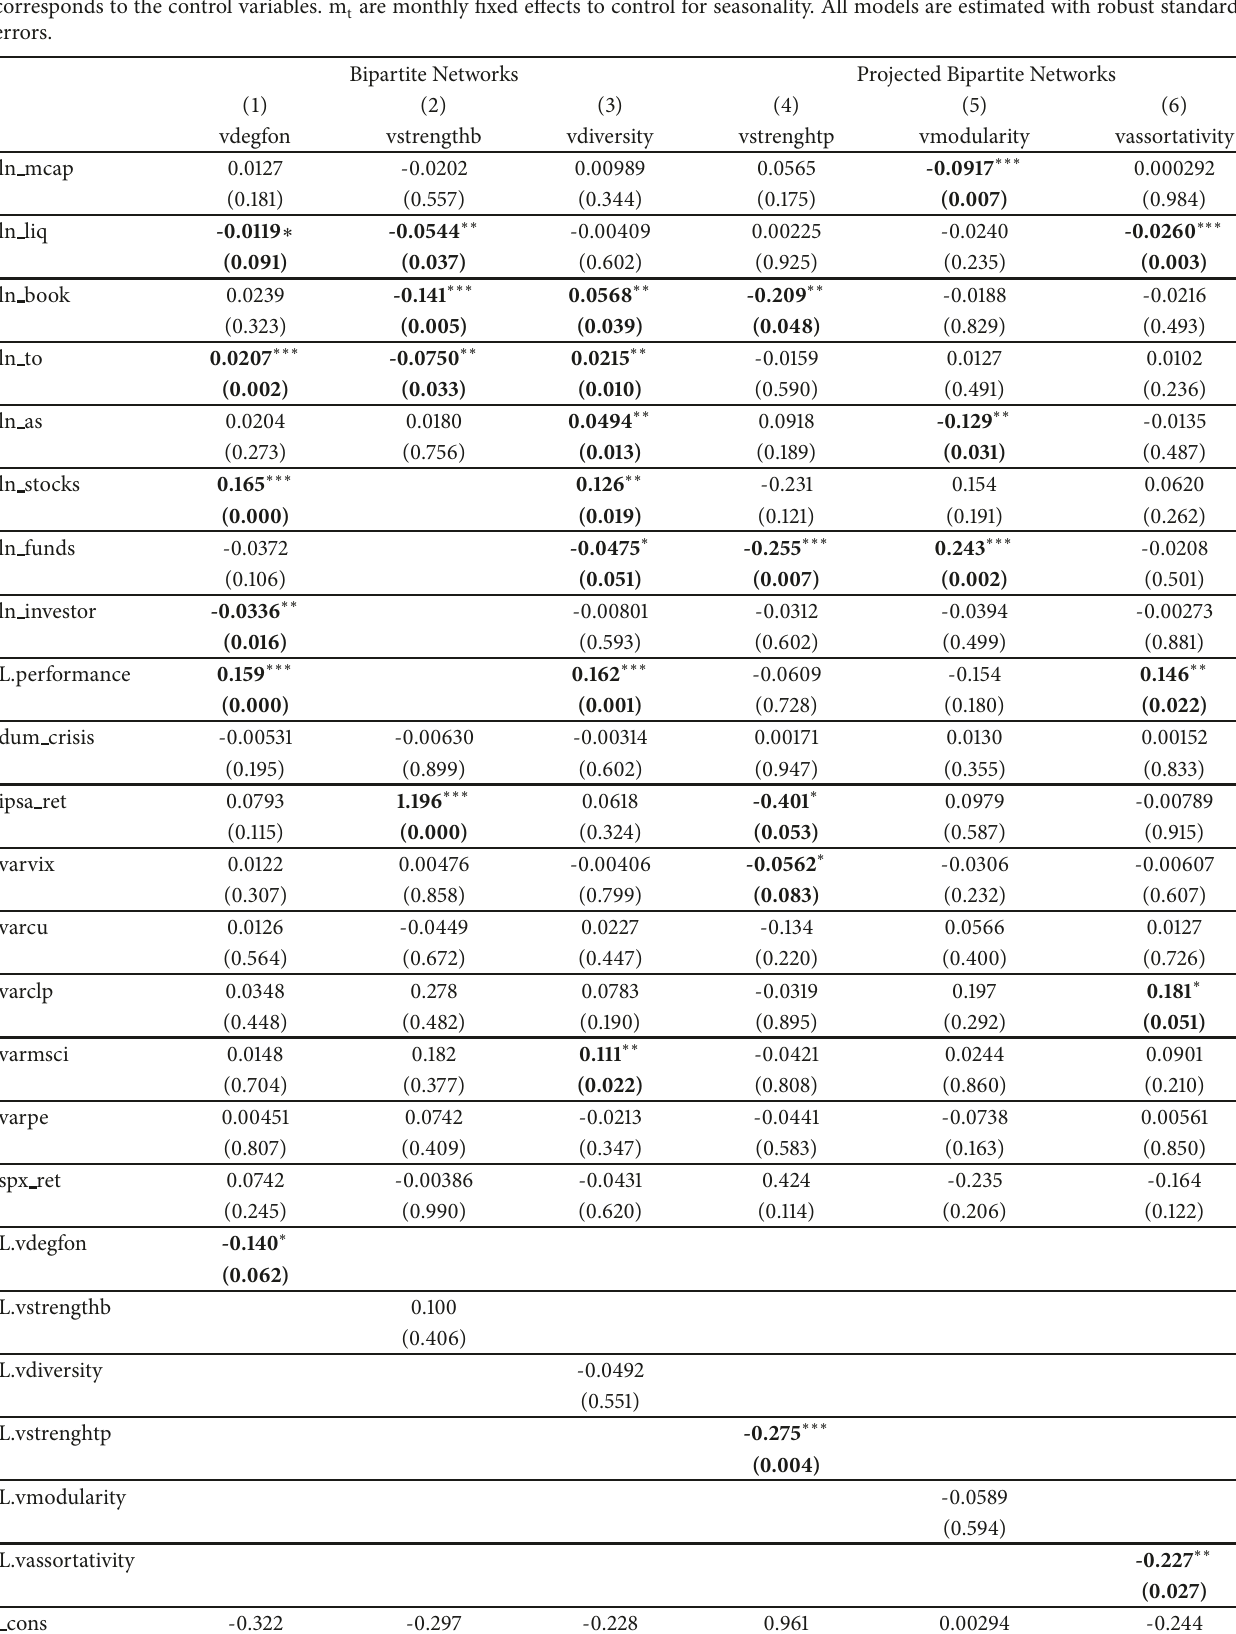
Table 3: Robustness Models. This table summarizes the results of the following model: Y t = 𝛼 + 𝛽 ∗ X t + 𝛾 ∗ C t + m t + 𝜀 t . The dependent variable is Y t and represent the variation in the topological variables of the bipartite networks. X t corresponds to the independent variables. C t corresponds to the control variables. m t are monthly fixed effects to control for seasonality. All models are estimated with robust standard